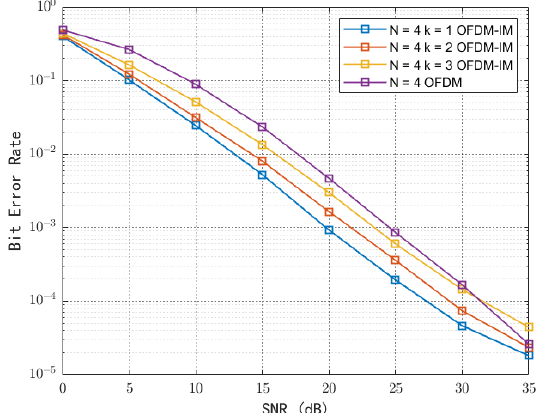
Figure 7. Reflection coefficient and number of device decodes. Figure 7. Re fl ection coe ffi cient and number of device decodes.